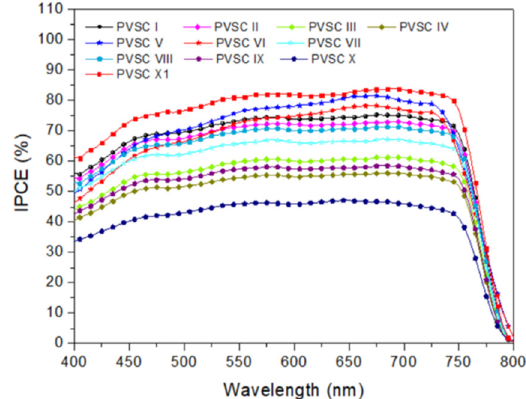
Figure 13. IPCE spectra of PVSCs fabricated from the cellulose derivative–modified NiO x HTLs, recorded under monochromatic irradiation.